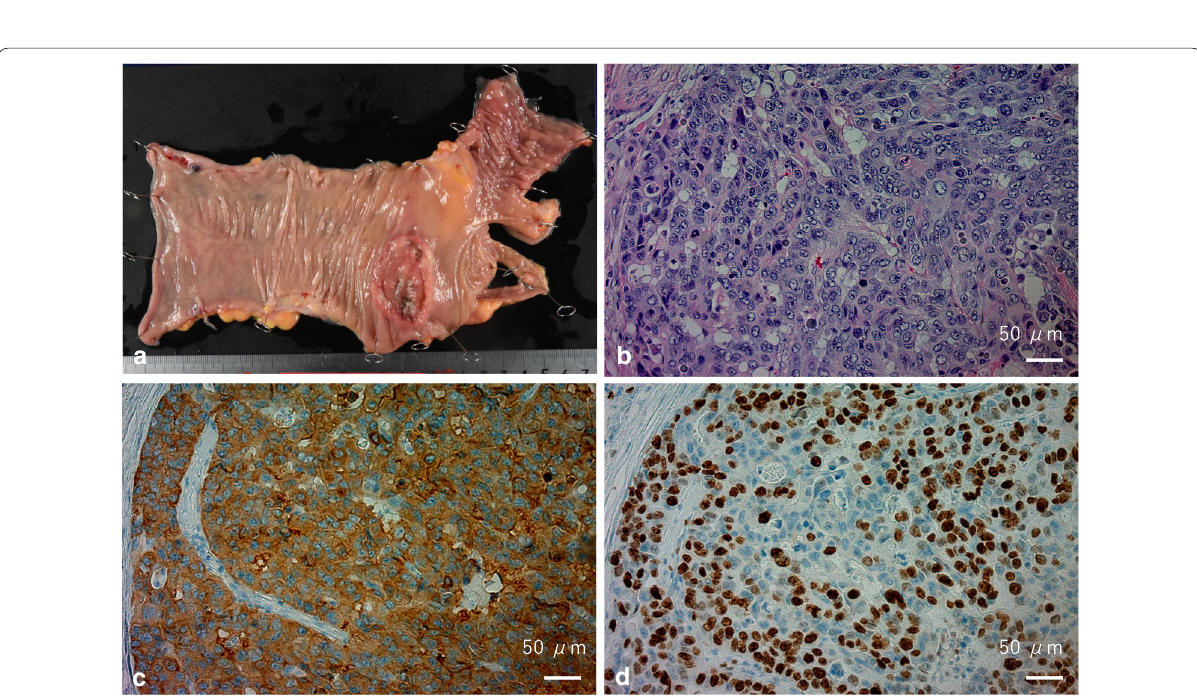
Fig. 3 a Resected specimen of the semicircular type 3 tumor in the ascending colon. Histological findings with b hematoxylin and eosin staining, c synaptophysin, and d MIB-1 immunohistochemical